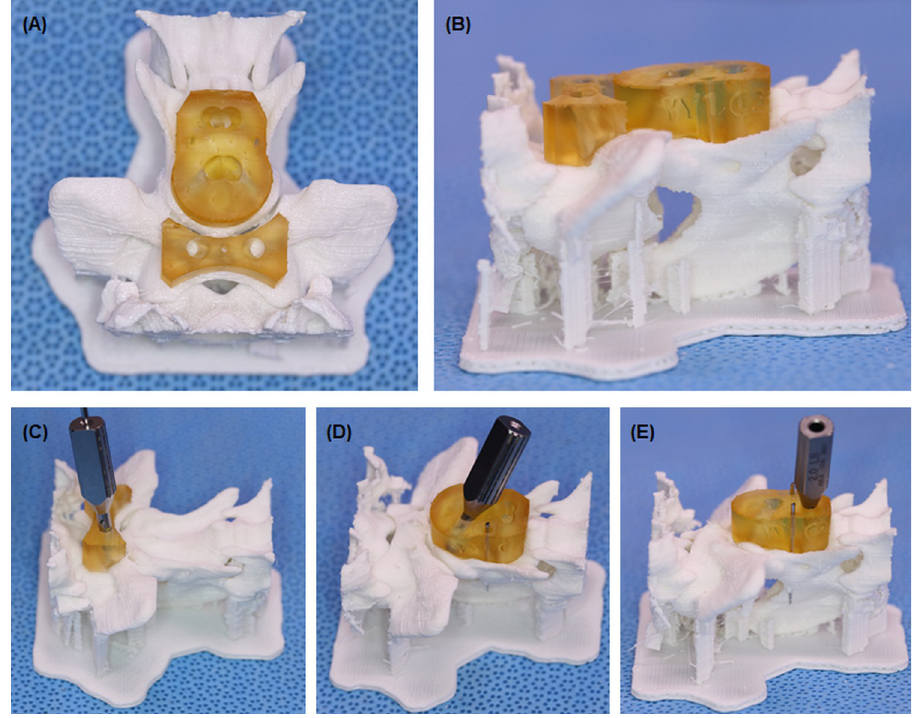
Fig 2. The C1 and C2 guides on the 3D-printed bone model and the drill sleeves. Dorsal view (A) and lateral view (B) of the patient-specific guides on the bone model. The drill sleeve at the C1 guide hole (C). (D) The drill sleeve at the cranial hole of the C2 guide. (E) The drill sleeve at the caudal hole of the C2 guide.